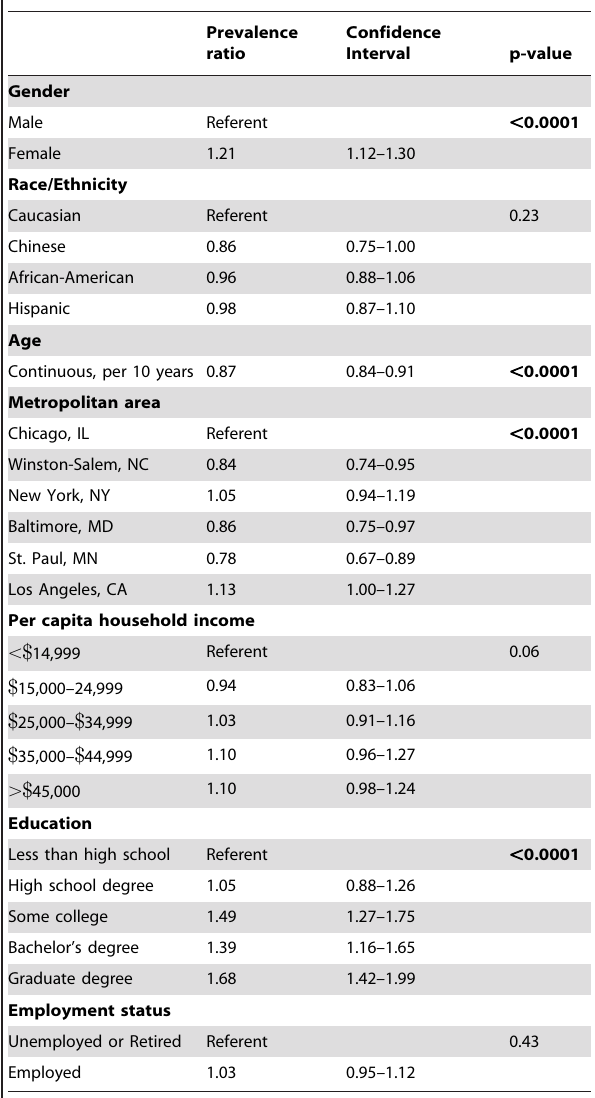
Table 2. Prevalence ratios and 95% confidence intervals for the association between organic food consumption and individual-level demographic and socioeconomic characteristics in adjusted